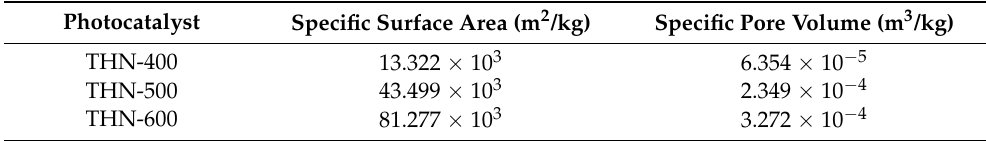
Table 1. Specific surface area and pore volume of hollow